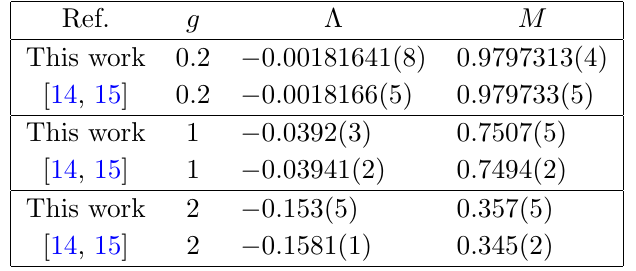
Table 6 . The values (cid:3) and M for di(cid:11)erent values of g and comparison with refs. [14,